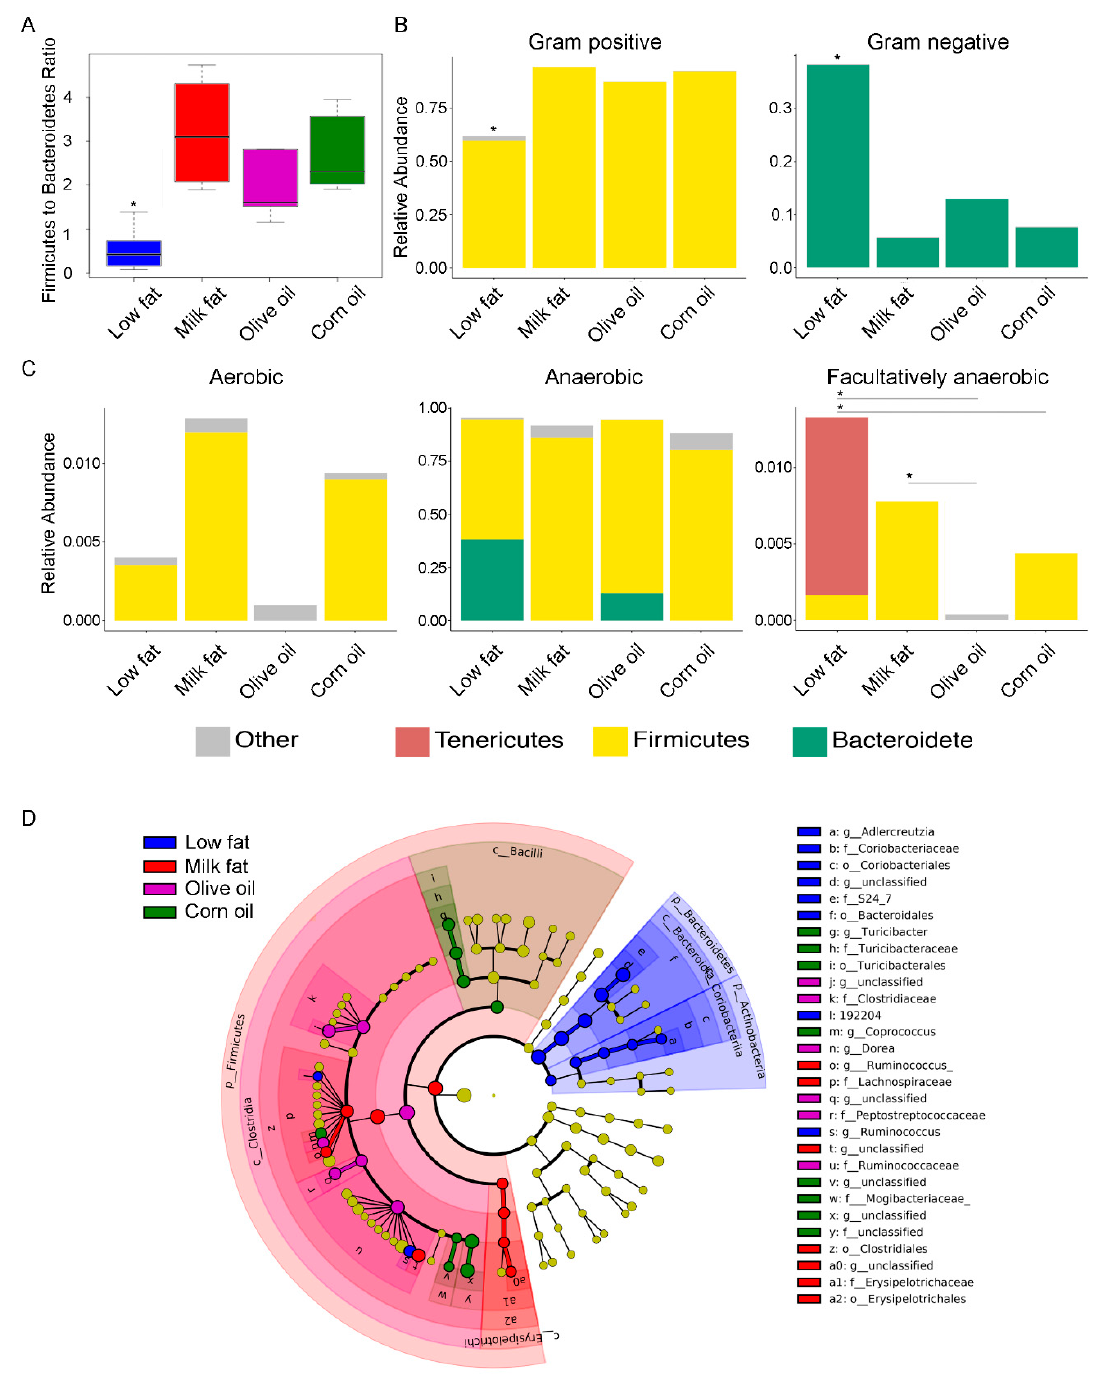
Figure 2. The effect of lipid diets on the gut microbial taxa. ( A ) Comparison of the log abundance of the Firmicutes to Bacteroidetes ratio among experimental diet groups in the colon. The y-axis of the box plot indicates the log of the abundance of the Firmicutes divided by the abundance of Bacteroidetes. The low-fat group had a significantly lower Firmicutes to Bacteroidetes ratio than all the high-fat diets. Within the high-fat diets, olive oil had a significantly lower ratio of Firmicutes to Bacteroidetes than the milk fat group. ( B ) Relative abundances of Gram-positive and Gram-negative bacteria in the diet groups show a significantly lower abundance of gram positive bacteria and a corresponding higher abundance of gram negative bacteria in the low-fat dietary group. ( C ) Relative abundances of